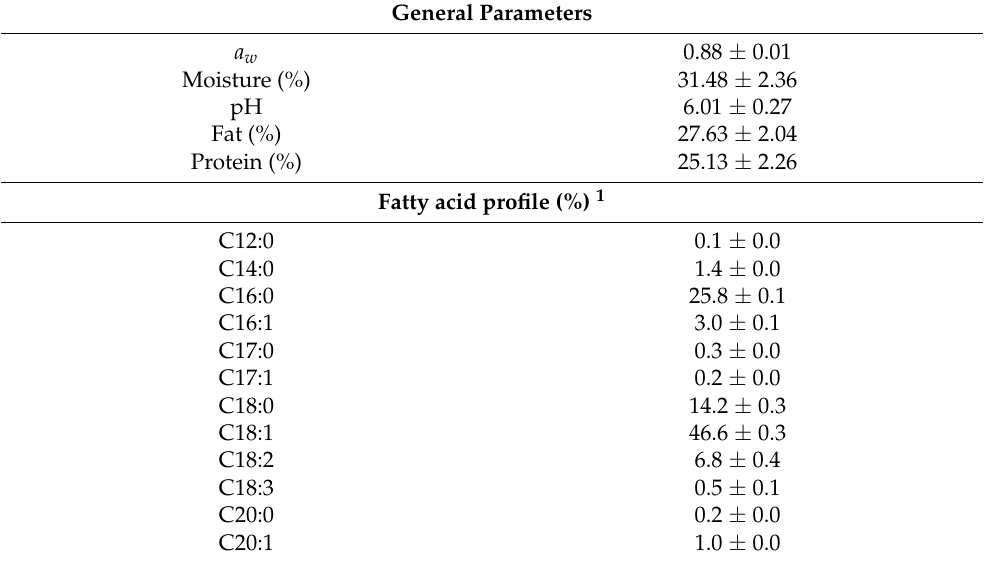
Table 1. Results for the physical-chemical parameters, proximate composition and fatty acid profile (mean ± standard deviation) of the sliced Iberian chorizo.